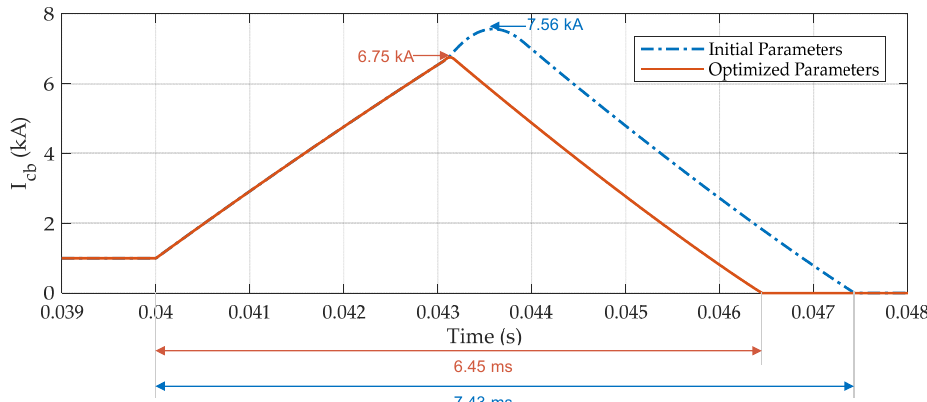
Figure 6. Current waveform of I cb of the HCB